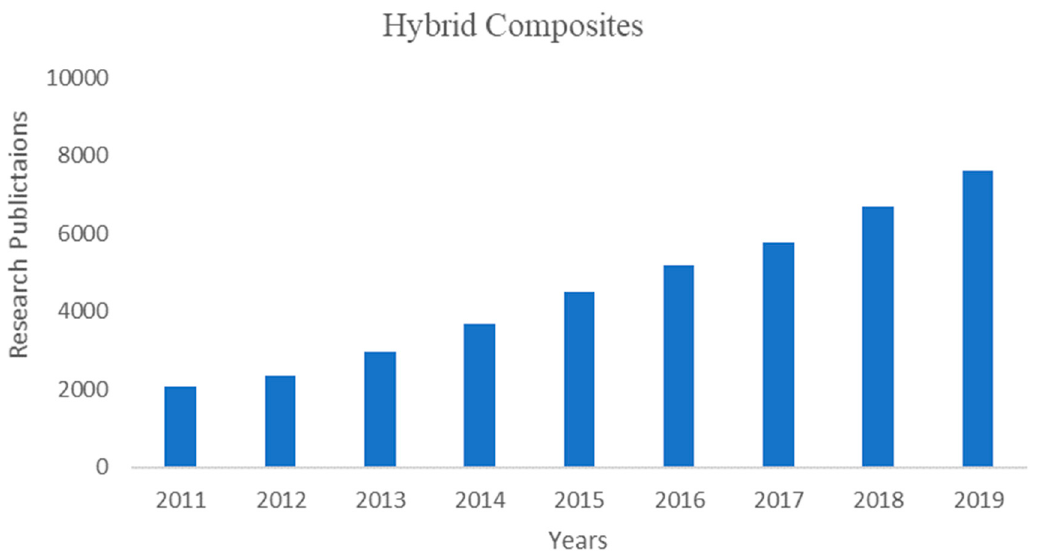
Figure 1. Recent publications on hybrid composites.